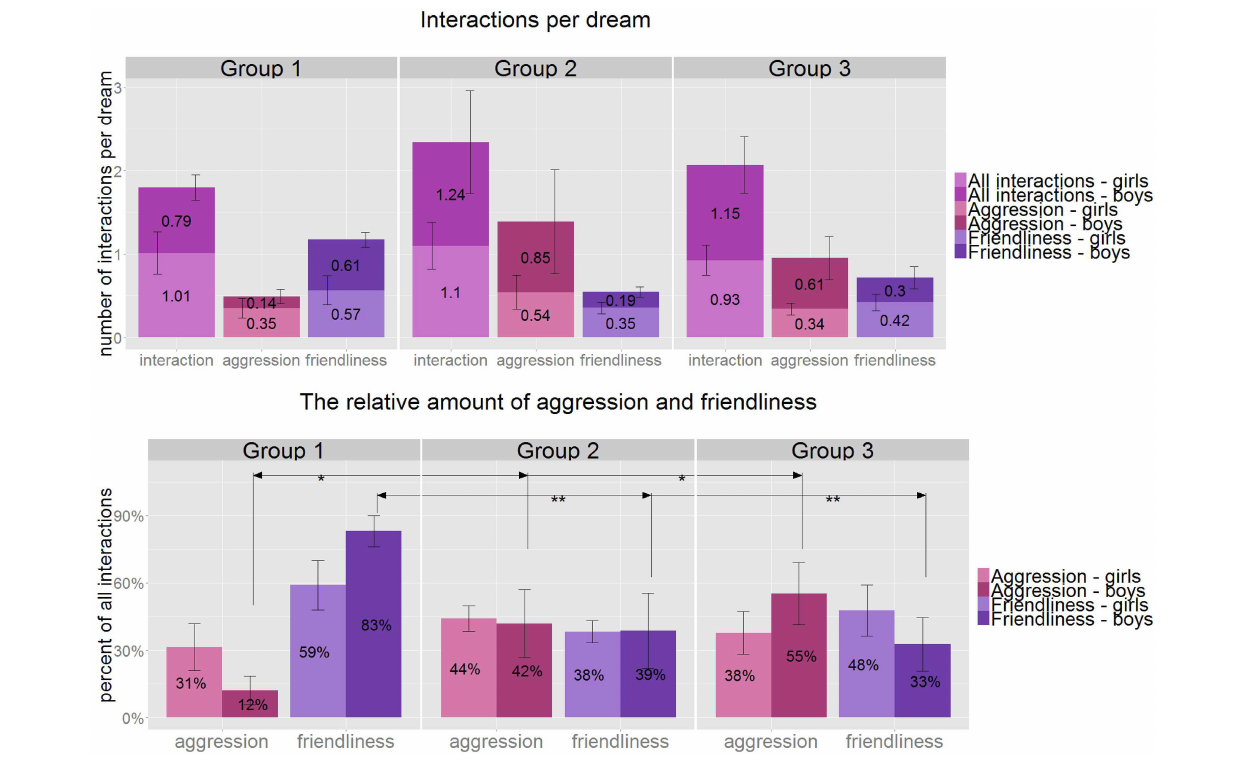
aggression from Group 1 to Group 2 and from Group 1 to Group 3, which is only significant amongst the boys and not the girls (although it stays significant without the gender split). Friendliness shows a significant decrease in the same pattern: from Group1 to 2 and from Group 1 to 3. * p < 0 . 05 , ** p < 0 . 01 , Group 1: 3.8–5.5 years, Group 2: 5.51–7 years, Group 3: 7.01–8.5